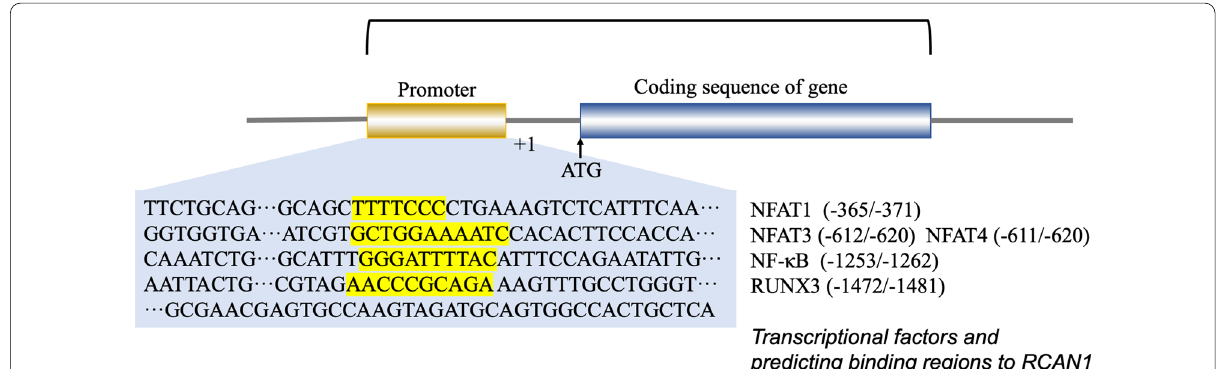
Fig. 3 Transcription factors and their predicted binding regions in RCAN1. The promoter sequence of RCAN1 and a list of transcription factors and their predicted binding regions in